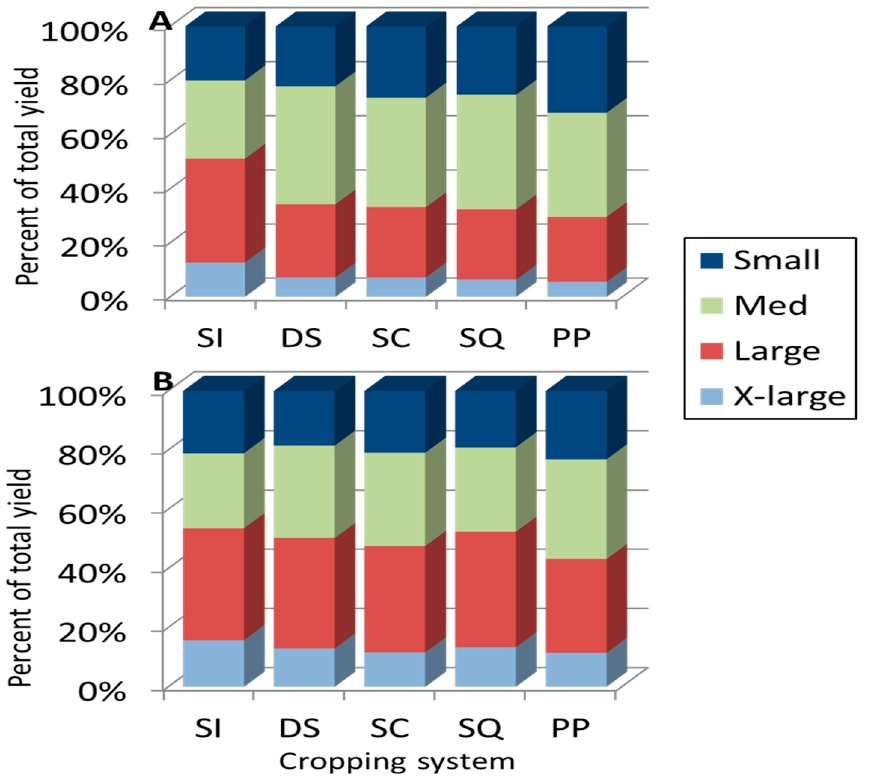
Figure 2. Effect of cropping system on average tuber size class distribution under ( A ) non-irrigated and ( B ) irrigated conditions as averaged over five cropping seasons (2006–2010).